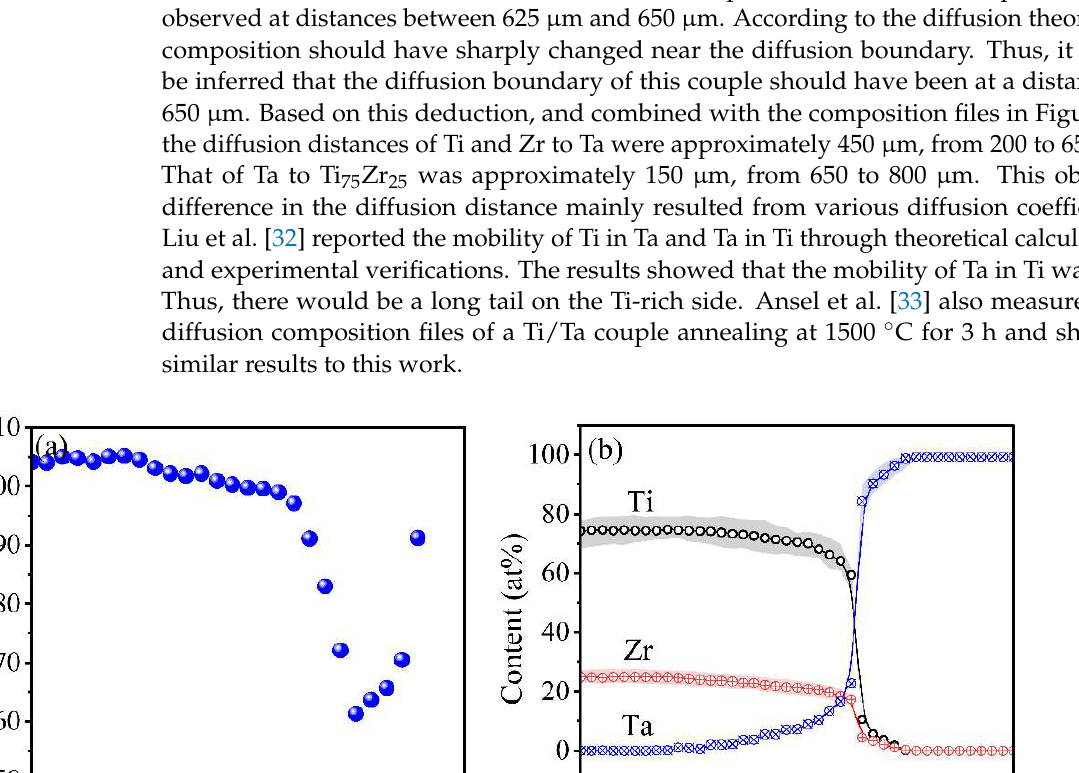
in Figure 3a. The points with an elastic modulus over 100 GPa on the Ta-rich side are not